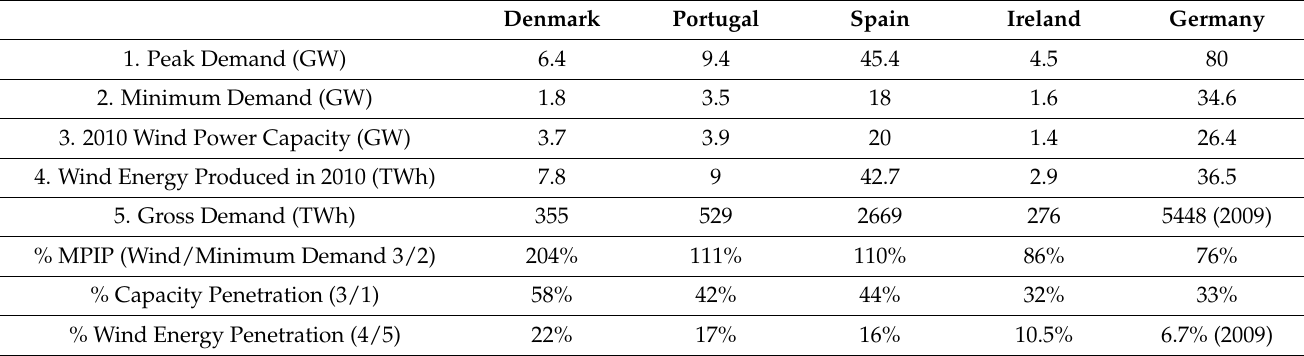
Table 1. Overview of some European wind penetration levels, based on 2010